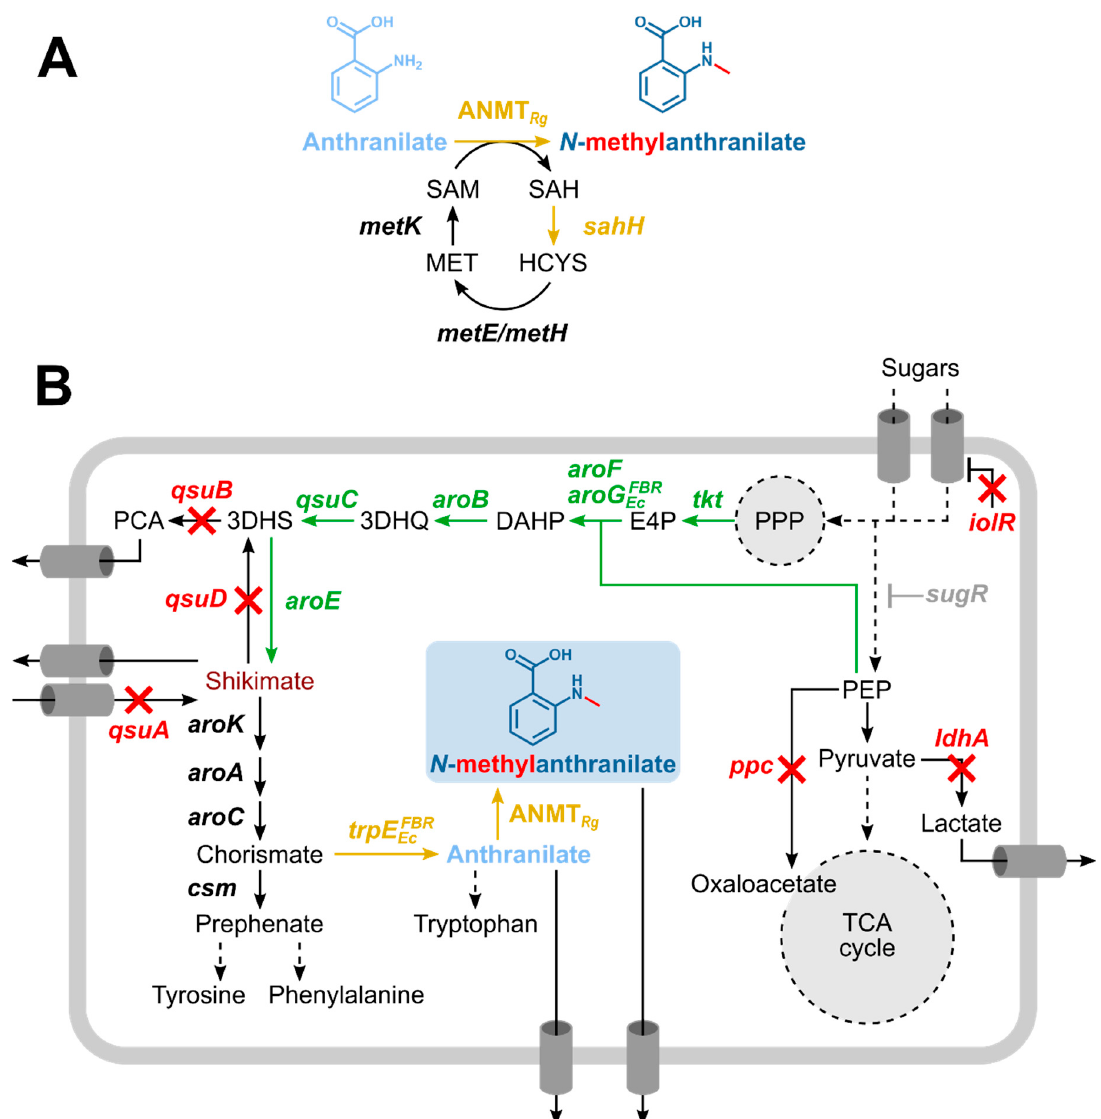
Figure 1. Schematic representation of N -methylanthranilate (NMA) biosynthesis ( A ) embedded into aromatic amino acid metabolism of engineered C. glutamicum ( B ). Continuous arrows indicate single reactions, dashed arrows indicate multiple reactions. Green arrows and gene names indicate genome-based overexpression, yellow arrows and gene names indicate vector-based expression, crossed arrows and red gene names indicate gene deletion. ( A ) N -methylation of anthranilate by N -methylanthranilate transferase (ANMT) from R. graveolens under consumption of S -adenosylmethionine (SAM). The SAM regeneration cycle is depicted with overexpression of sahH